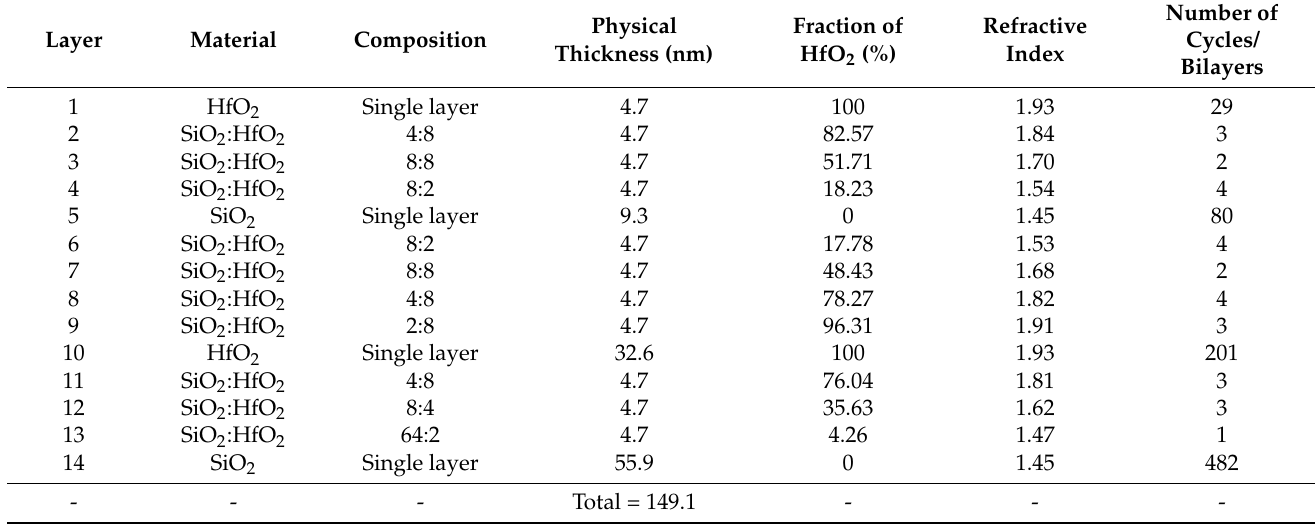
Table 5. Design of graded-index antireflection coatings at 355 nm